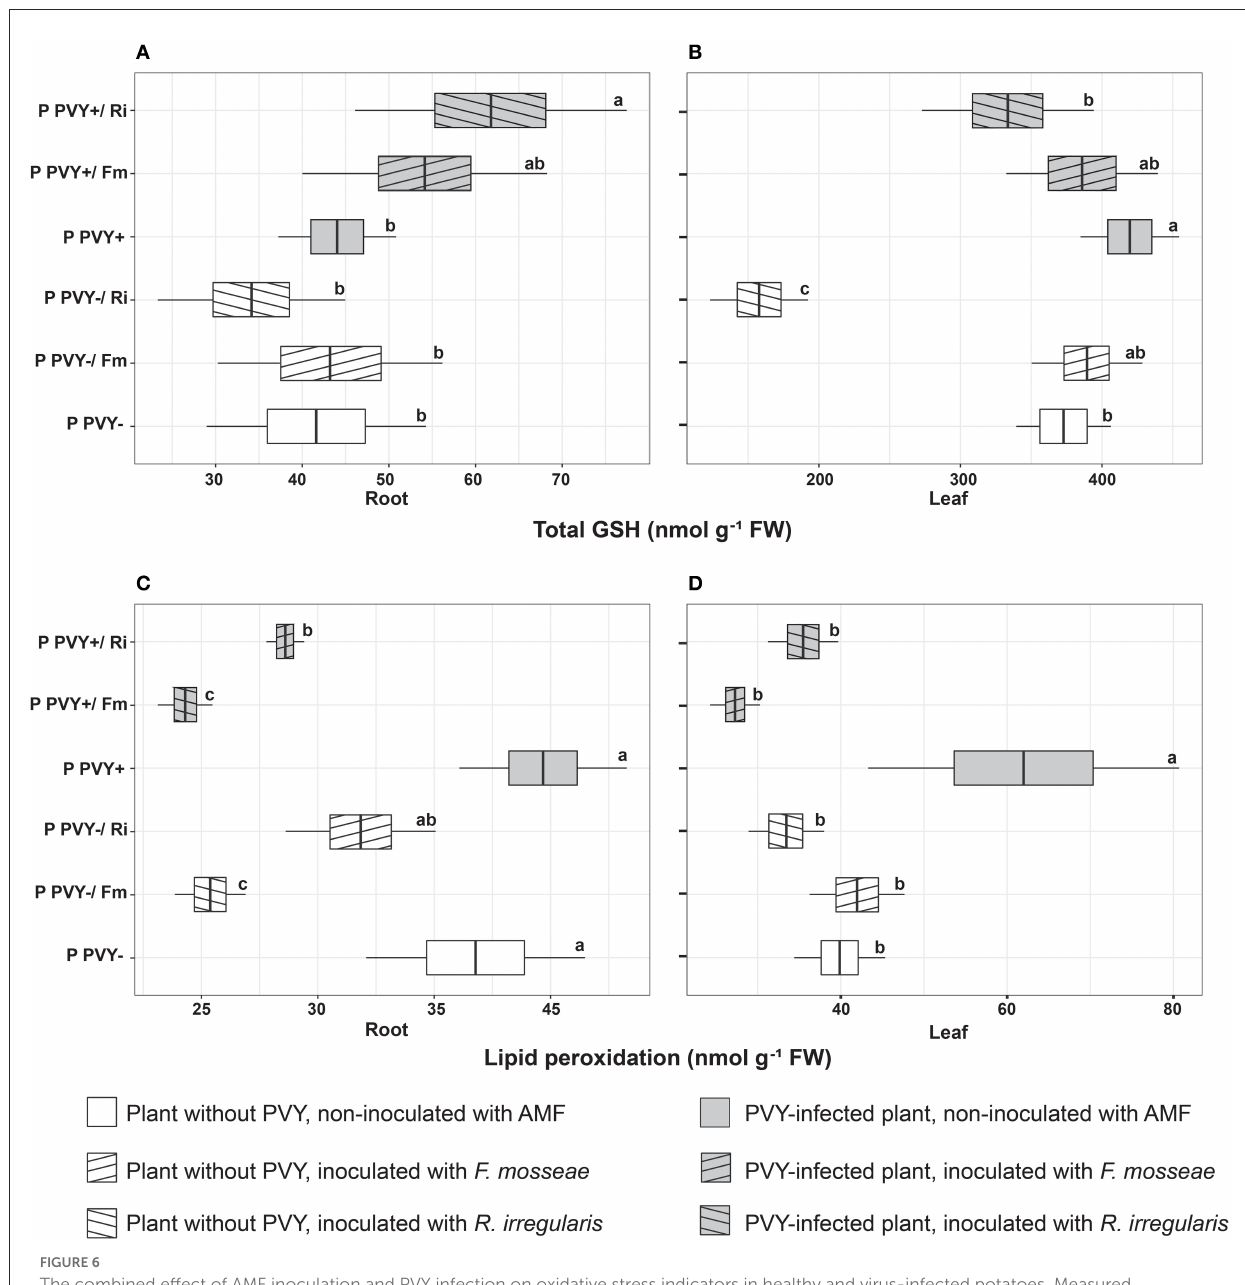
FIGURE6 The combined effect of AMF inoculation and PVY infection on oxidative stress indicators in healthy and virus-infected potatoes. Measured parameters included total root and leaf glutathione (A, B) and lipid peroxidation level in root and leaf (C, D) . The statistically significant differences are marked with letters. The same letters indicate no significant differences ( p >